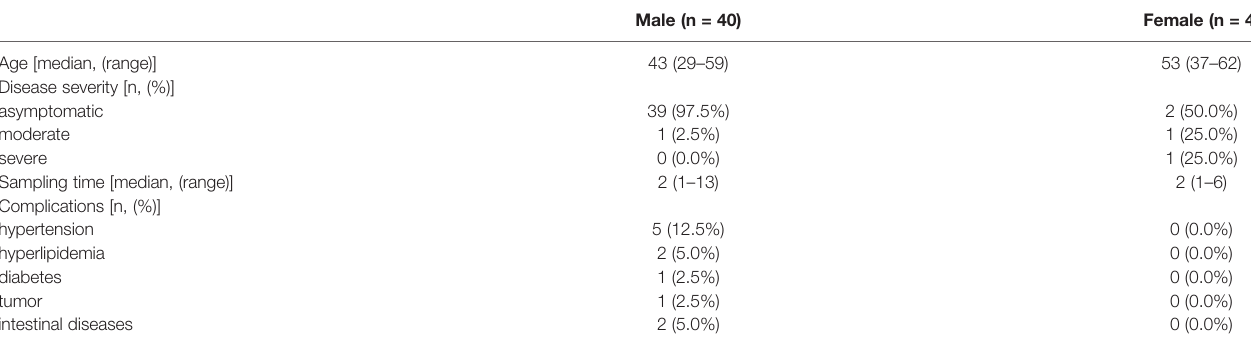
TABLE 1 | Characteristics of enrolled